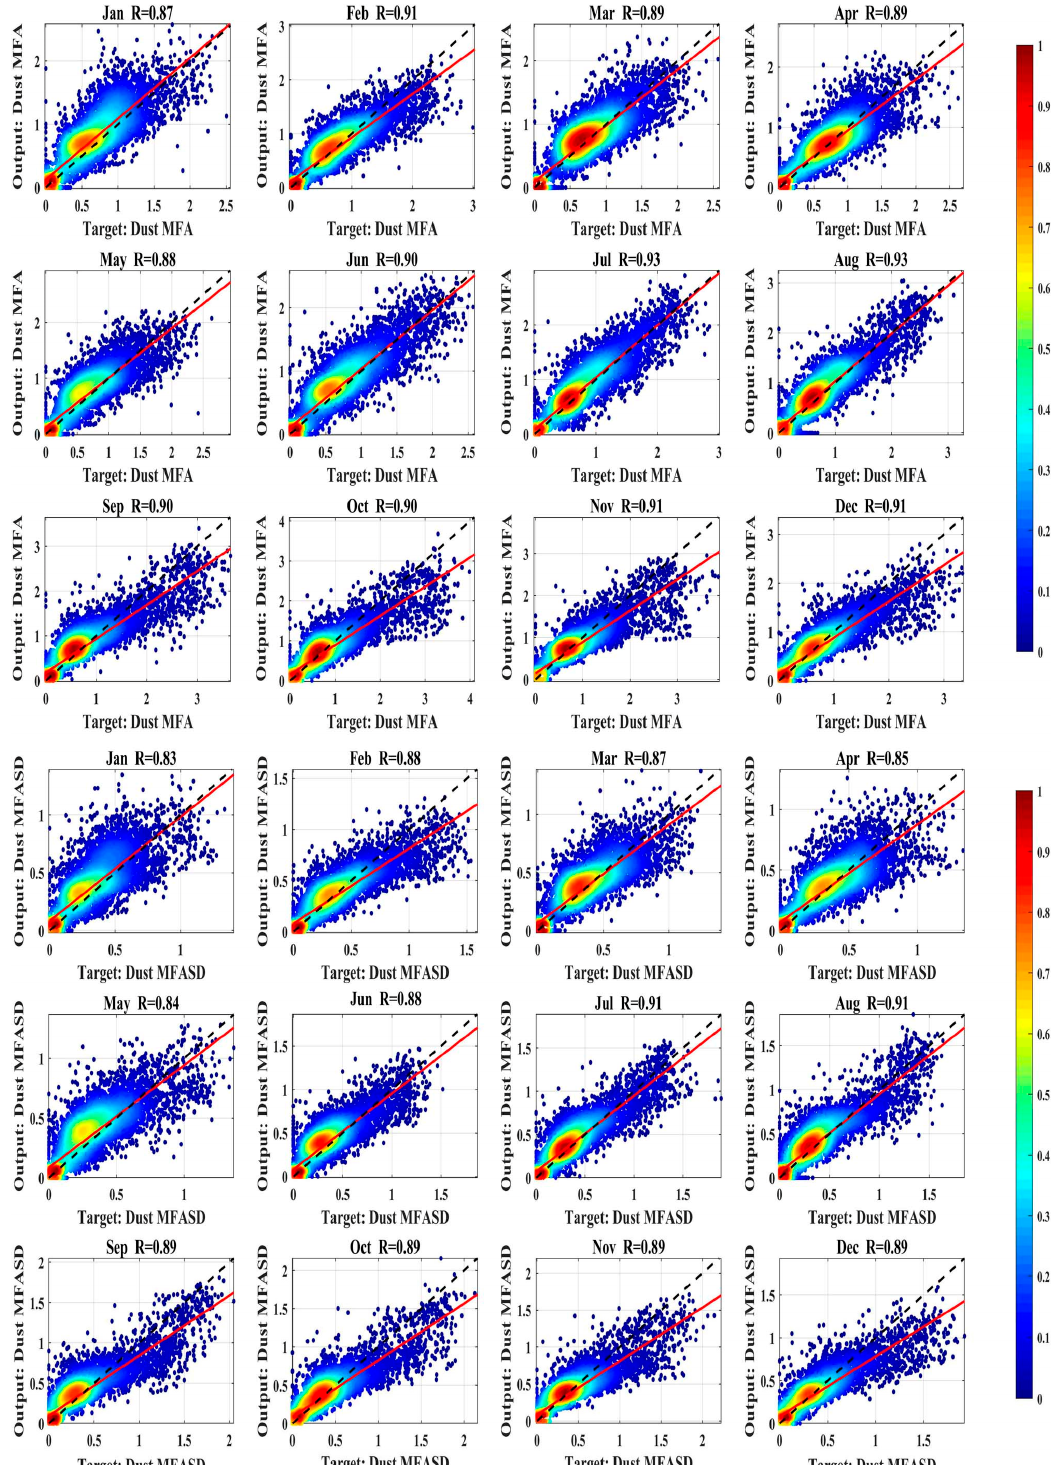
Figure 12. Correlation coefficients between model predicted and CALIPSO observed values of dust aerosol MFA (km) and MFASD (km) in different months.